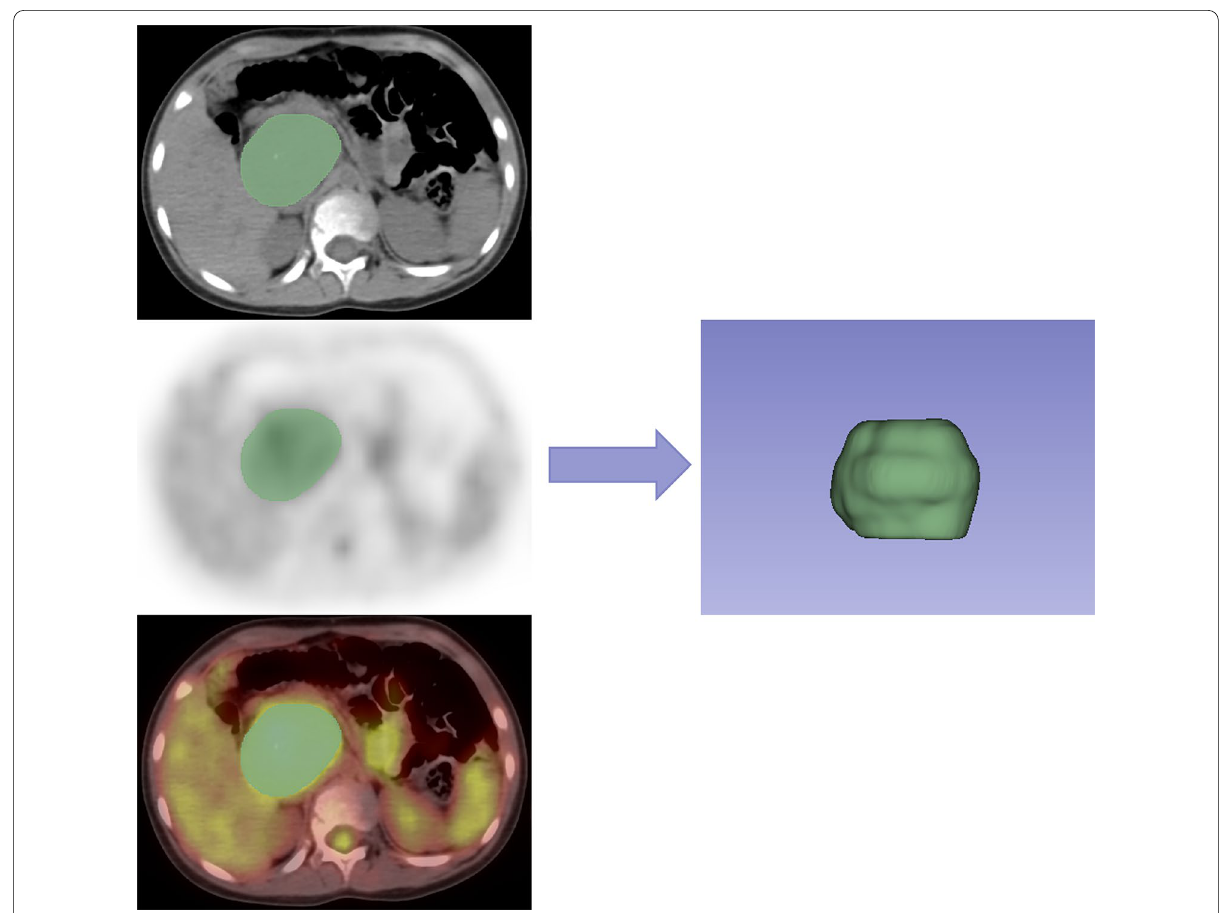
Fig. 2 Schematic representation of the tumor segmentation by 3D